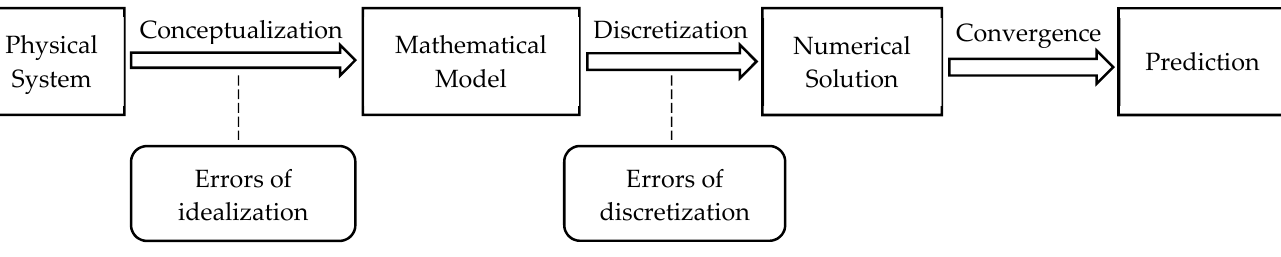
Figure 2. Development of FEM [56].